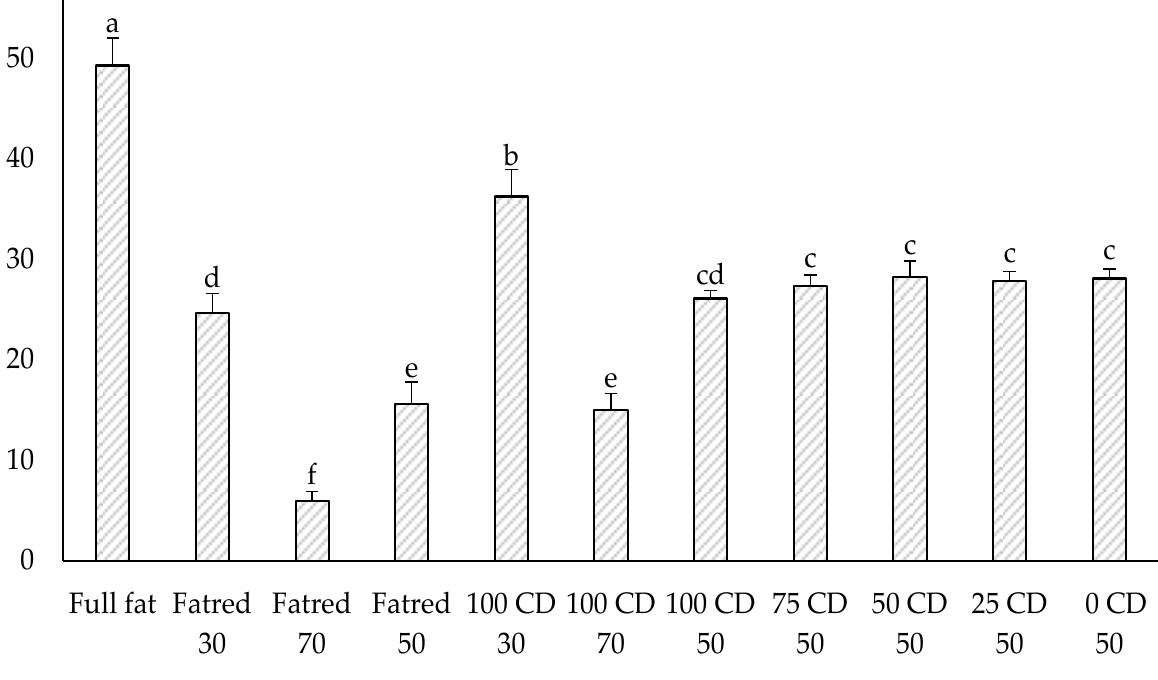
Figure 3. Viscosity of the PCS samples determined with an RVA. The data are expressed as mean ± standard deviation ( n > 12). Bars with different letters indicate significant differences between samples ( p ≤ 0.05) following one-way ANOVA (Tukey).